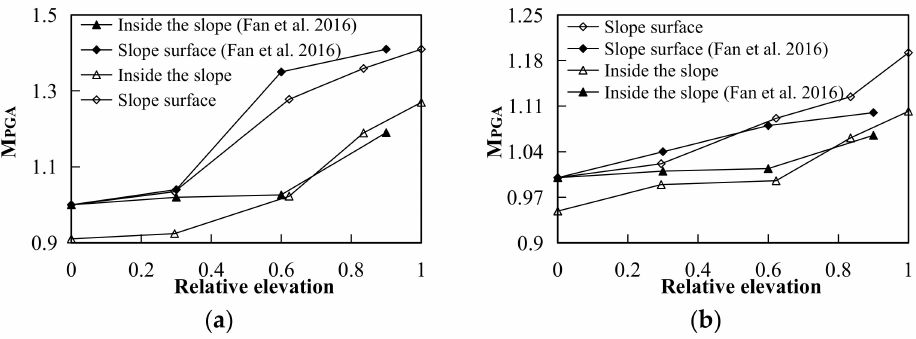
Figure 10. M PGA change rule of the slope when inputting WE wave: ( a ) when input in x direction, ( b ) when input in z